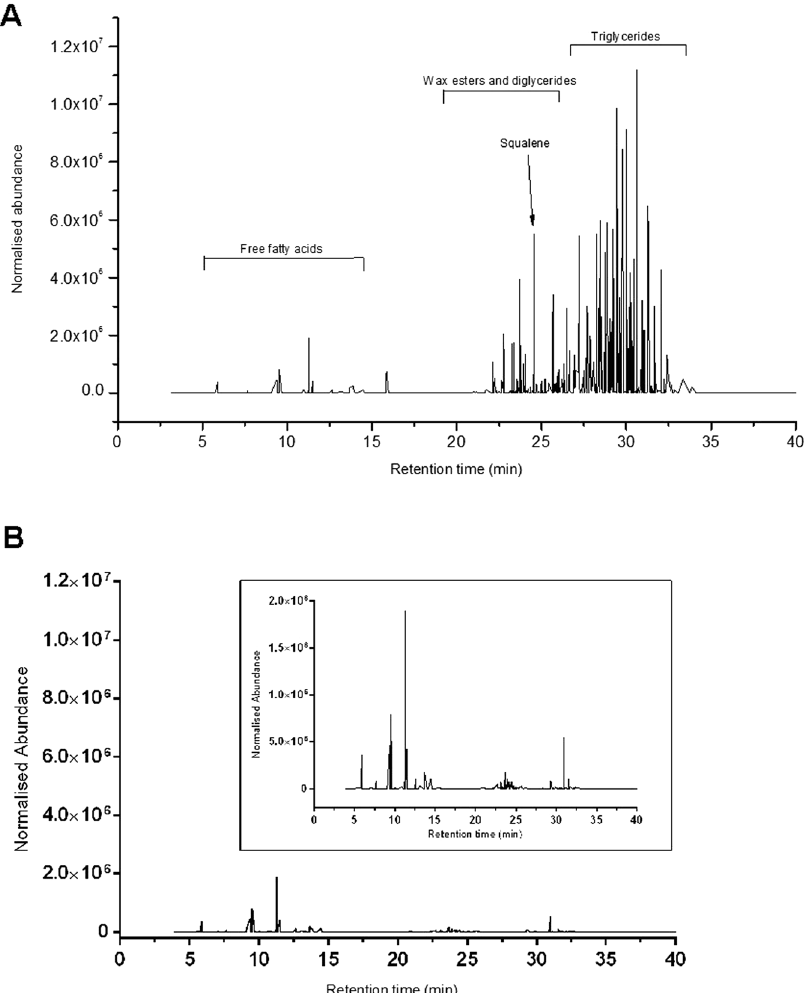
Figure 1. Representative chromatogram of human residual skin surface components. Distributions were reconstructed based on the normalised abundance of compound ions detected in both positive and negative ionisation analysis ( A ) and negative ionisation analysis only ( B ); showing inset zoom-in) by high performance liquid chromatography with atmospheric pressure chemical ionization mass spectrometry.